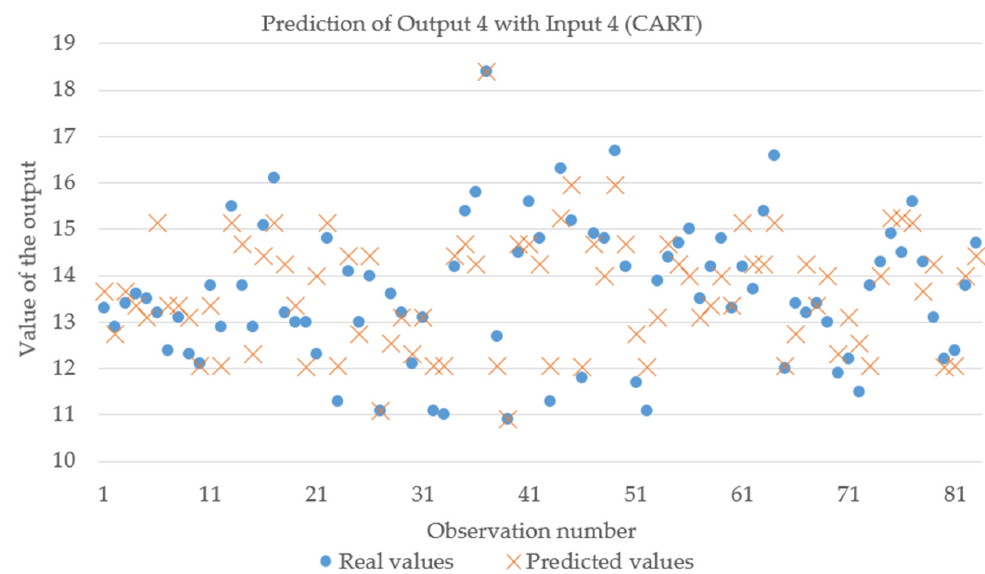
Figure 3. Prediction of Output 4 with the trained CART model from Input 4.